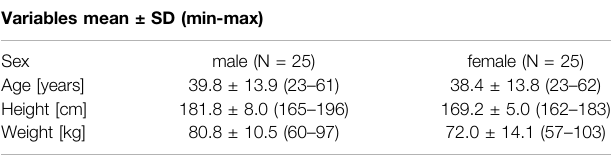
TABLE 1 | Anthropometric data of the participants. Data are presented as means ± standard deviation (Range). Variables mean ± SD